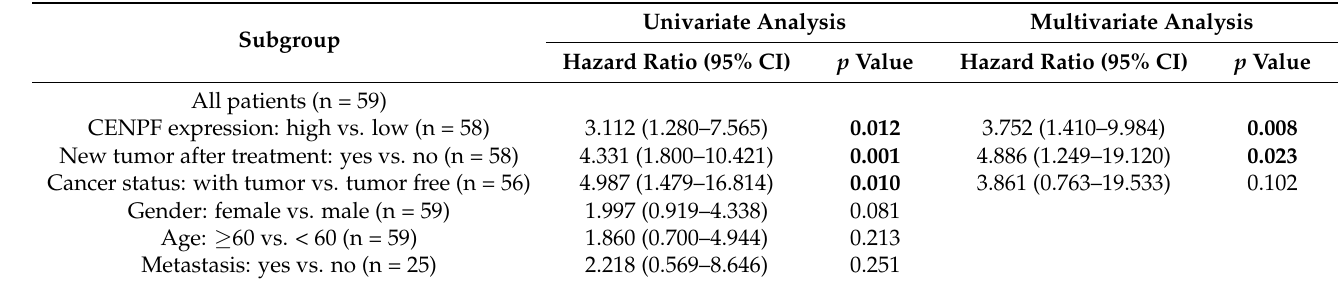
Table 1. Univariate and multivariate analysis of factors associated with LPS survival. The bold number indicates the significance ( p <